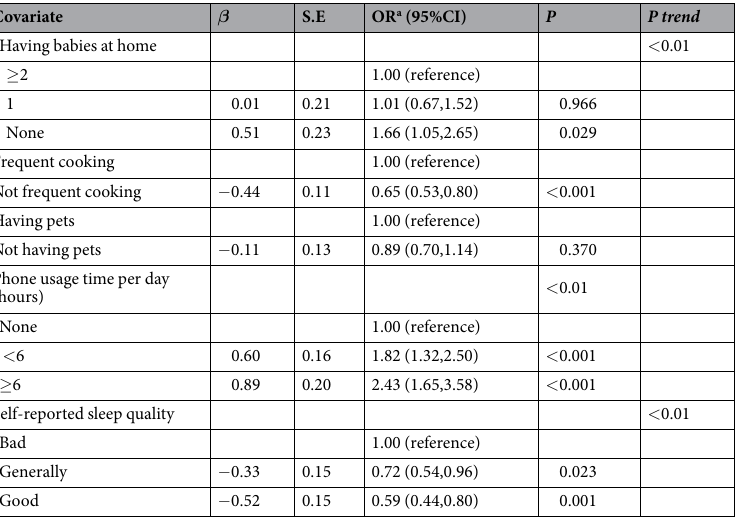
Table 3. Multivariate ordinal logistic regression: associations of selected lifestyles and prenatal stress. β , standardised regression coefficients. S.E, standard error. OR, odds ratio. 95% CI, 95% confidence interval. a ORs were adjusted for maternal age, pre-pregnancy Body Mass Index (BMI), gravidity history.